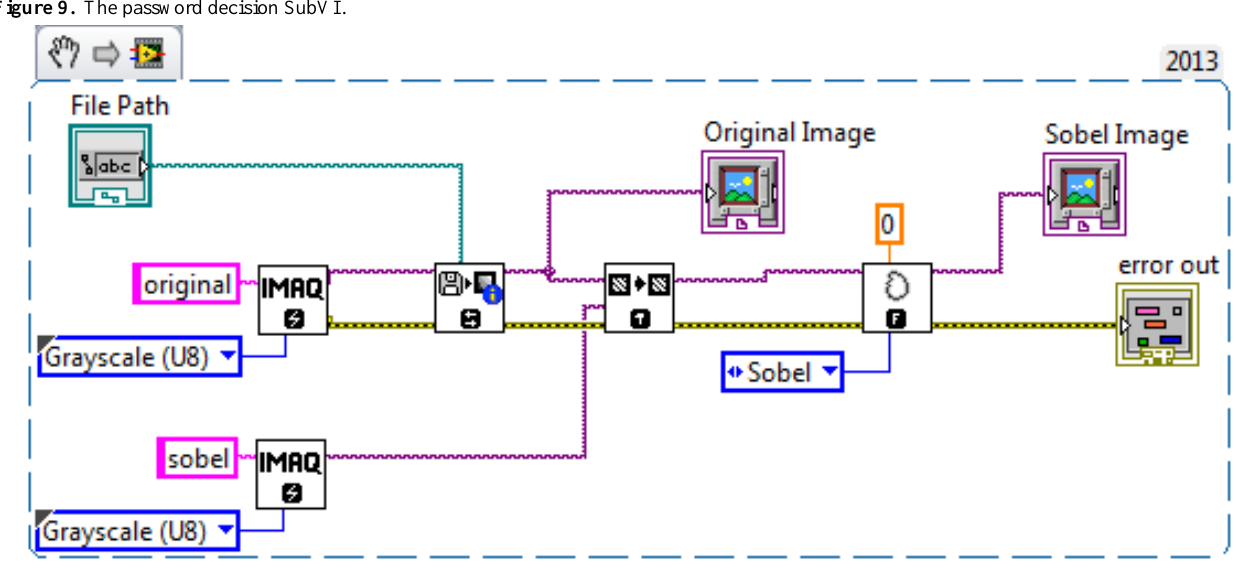
Figure 9. The password decision